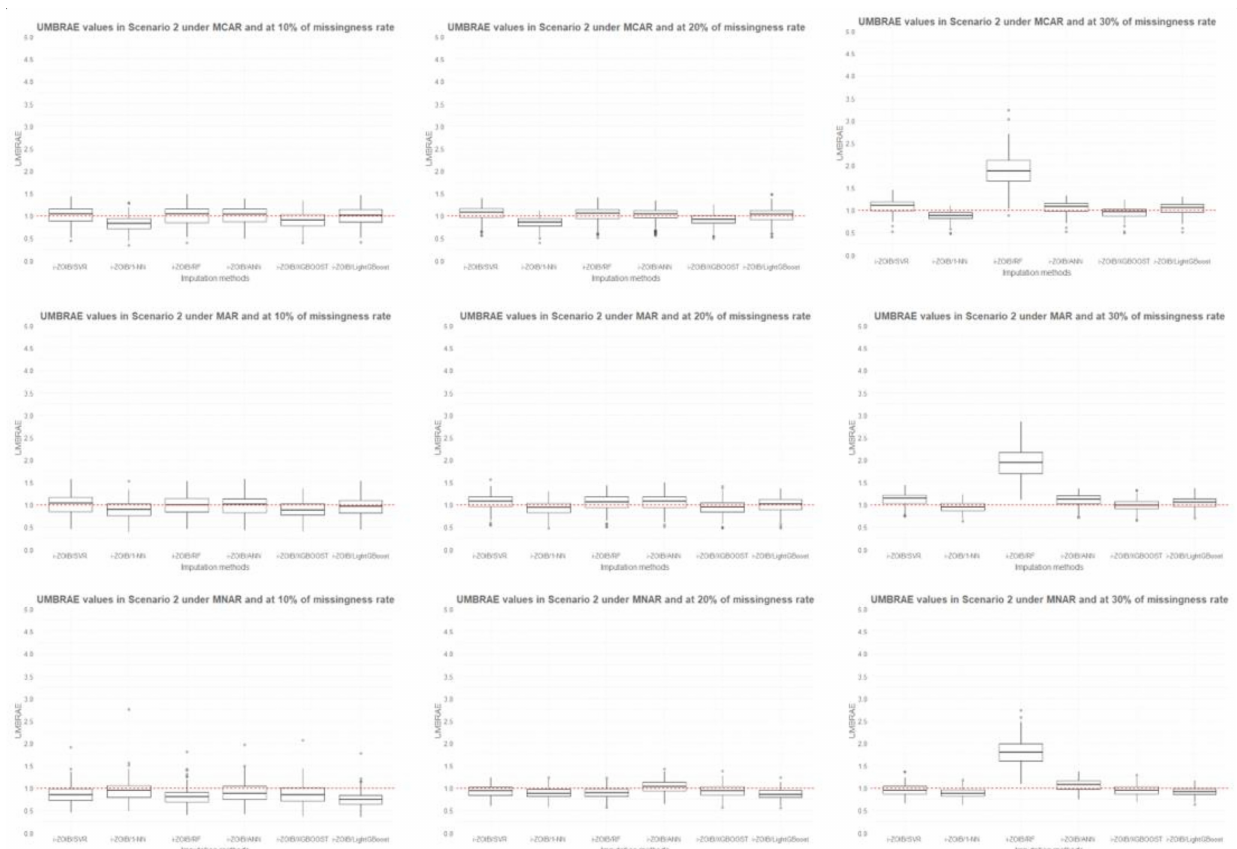
Figure 6. Boxplots of UMBRAE values according to the missingness mechanisms and rates in the Scenario